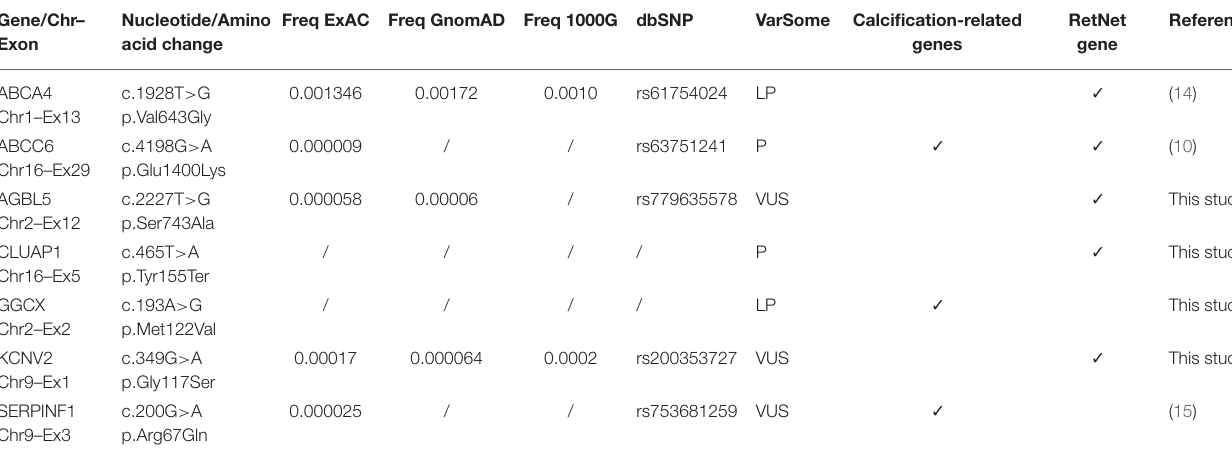
TABLE 1 | List of rare sequence variants found in patient in heterozygous